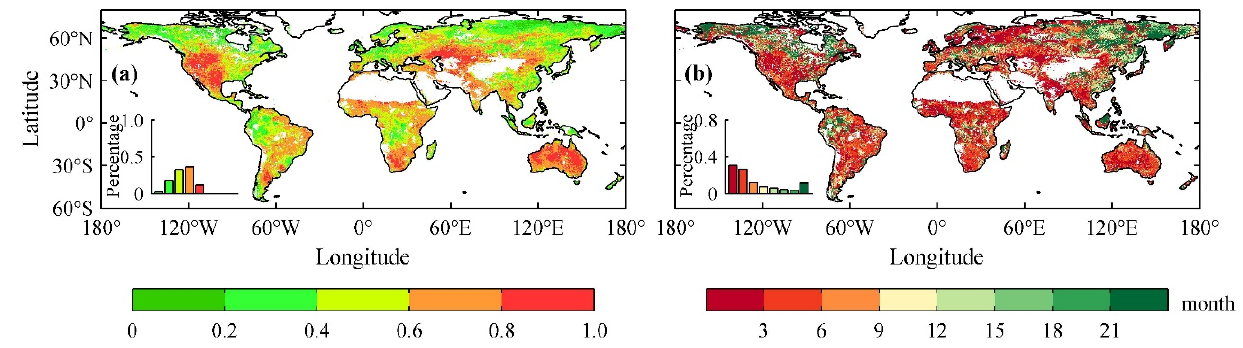
Figure 4. Geographical patterns of vegetation productivity’s dependence upon, and response to, water availability. ( a ) Spatial distribution of the maximum correlation coefficients recorded between LUE GPP and SPEI in each pixel during 1982–2015. ( b ) SPEI timescales at which the maximum correlation coefficient between LUE GPP and SPEI was found over the period 1982–2015.